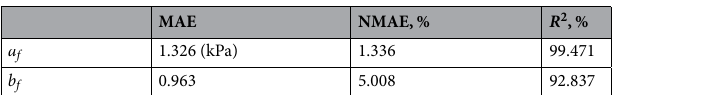
Table 1. ML prediction errors for testing dataset with final MFNN network structure and 10000 epochs.